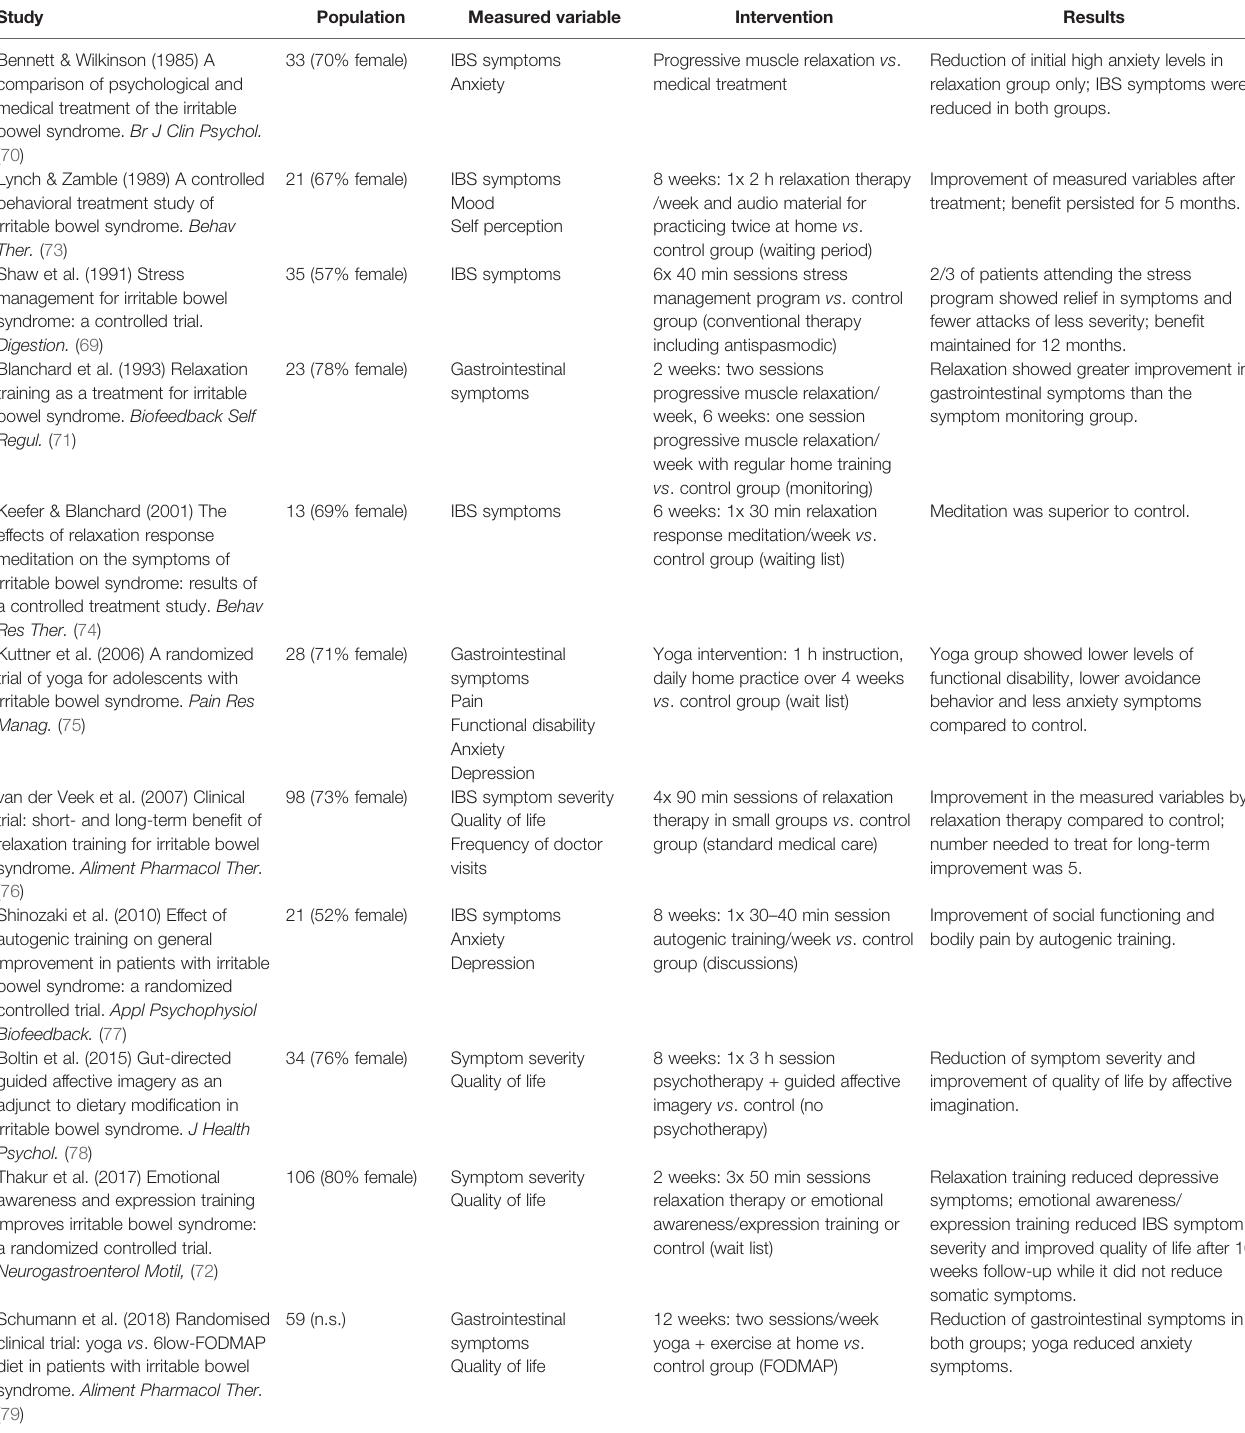
TABLE 7 | Randomized controlled studies investigating the effects of relaxation therapy in patients with irritable bowel syndrome. Study Population Measured variable Intervention Results 33 (70% female) IBS symptoms Progressive muscle relaxation vs . Reduction of initial high anxiety levels in Anxiety medical treatment relaxation group only; IBS symptoms were reduced in both